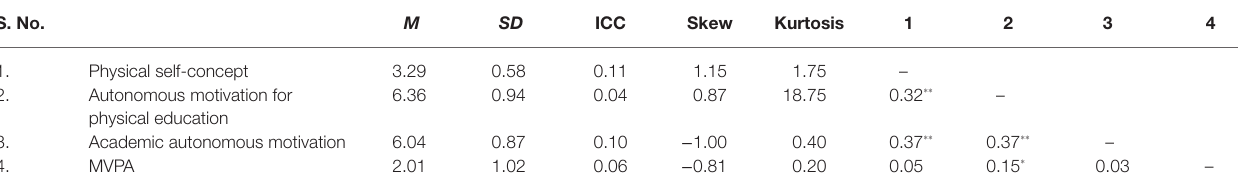
TABLE 1 | Means, standard deviations, and correlations among variables. S. No.